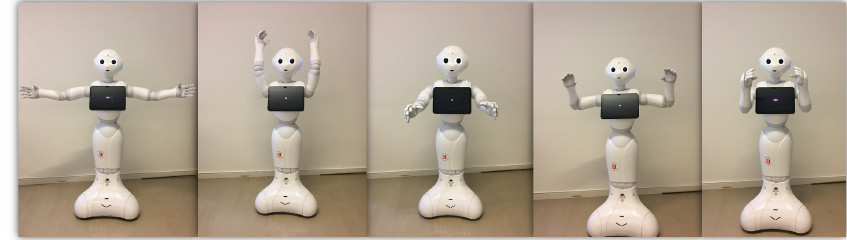
Figure 1. The basic arm motions of the Pepper robot. During the experiment, a random combinations of these motions were performed as a